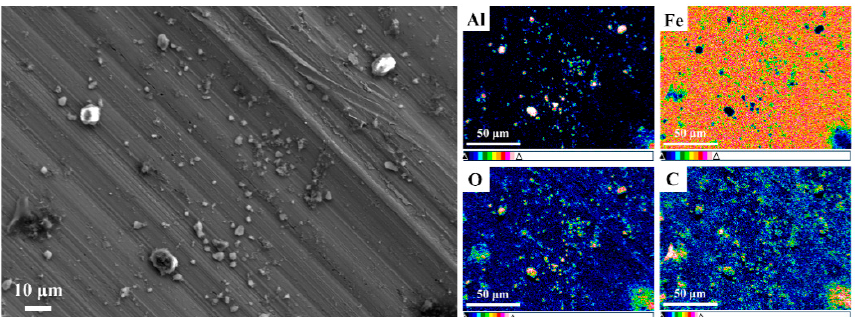
Figure 9. SEM micrograph of worn disk surface lubricated with 0.20 wt.% rGO-Al 2 O 3 nanofluid and EDS map scanning results.